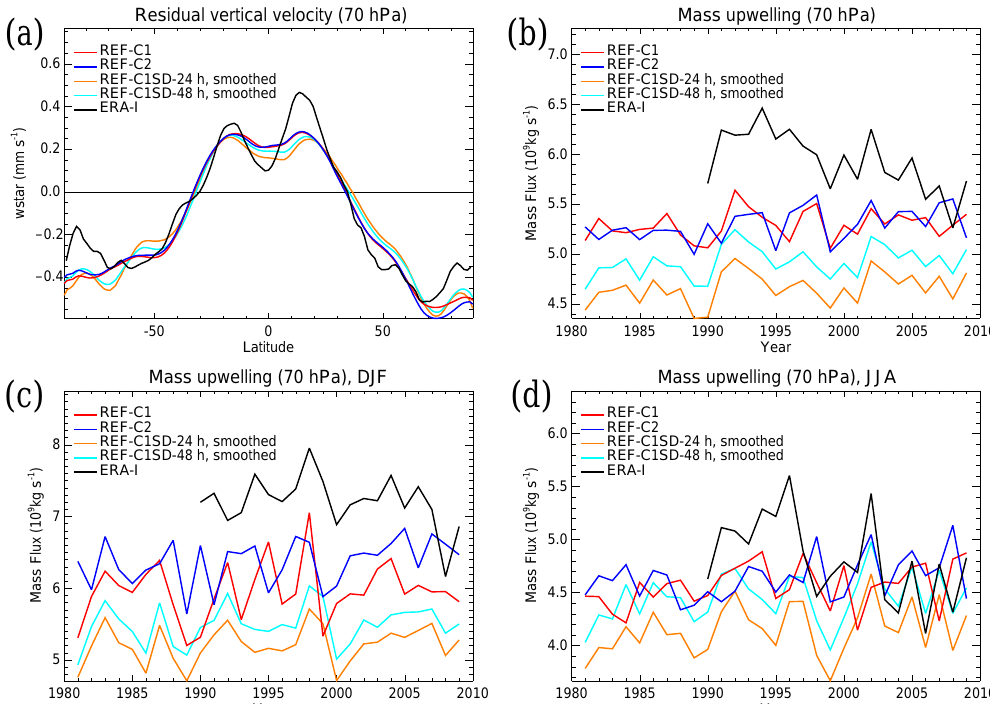
Figure 10. (a) Residual vertical velocity at 70hPa (1989–2009) and tropical mass upwelling through 70hPa for (b) annual mean, (c) December–January–February, and (d) June–July–August, as calculated for free-running simulations, nudged simulations, and ERA- Interim. Mass upwelling in (b) is calculated using seasonal means as in Butchart et al. (2010), such that the annual means plotted above the tick marks refer to December–November means.